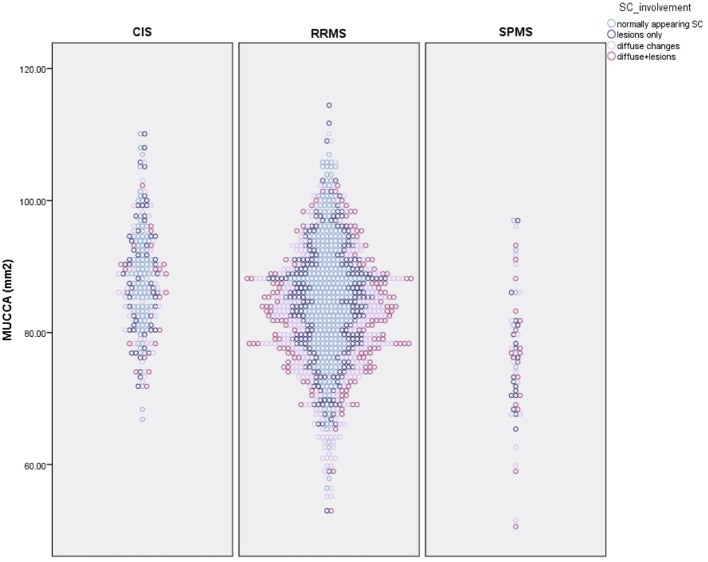
Distribution of spinal cord phenotypes in patients with CIS, RRMS, and SPMS and its association with spinal cord volume (MUCCA–mean upper cross-sectional cervical cord area).